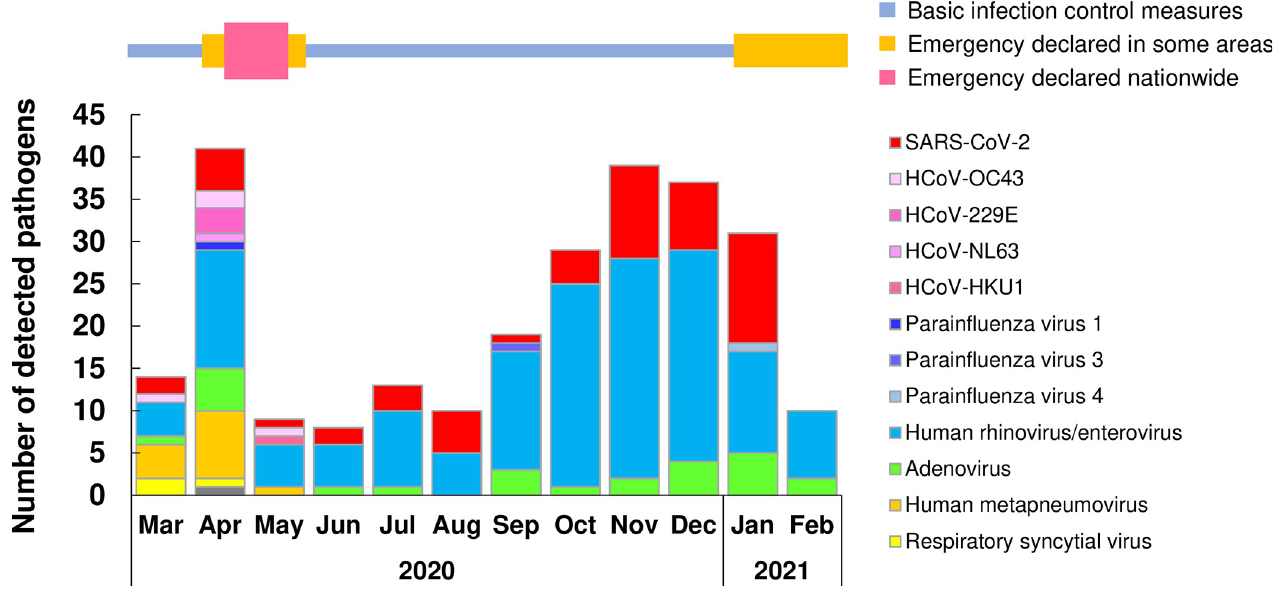
Fig 1. Trends in the circulation of SARS-CoV-2 and other respiratory pathogens during the COVID-19 pandemic.